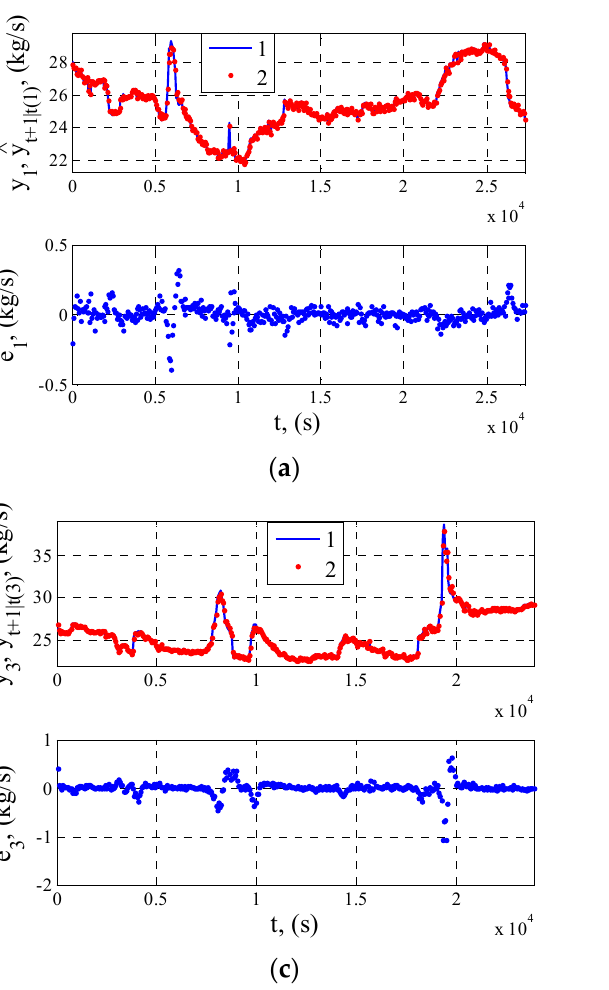
Table 5. Extreme values of the prediction error obtained on the basis of forecasts for four data series.